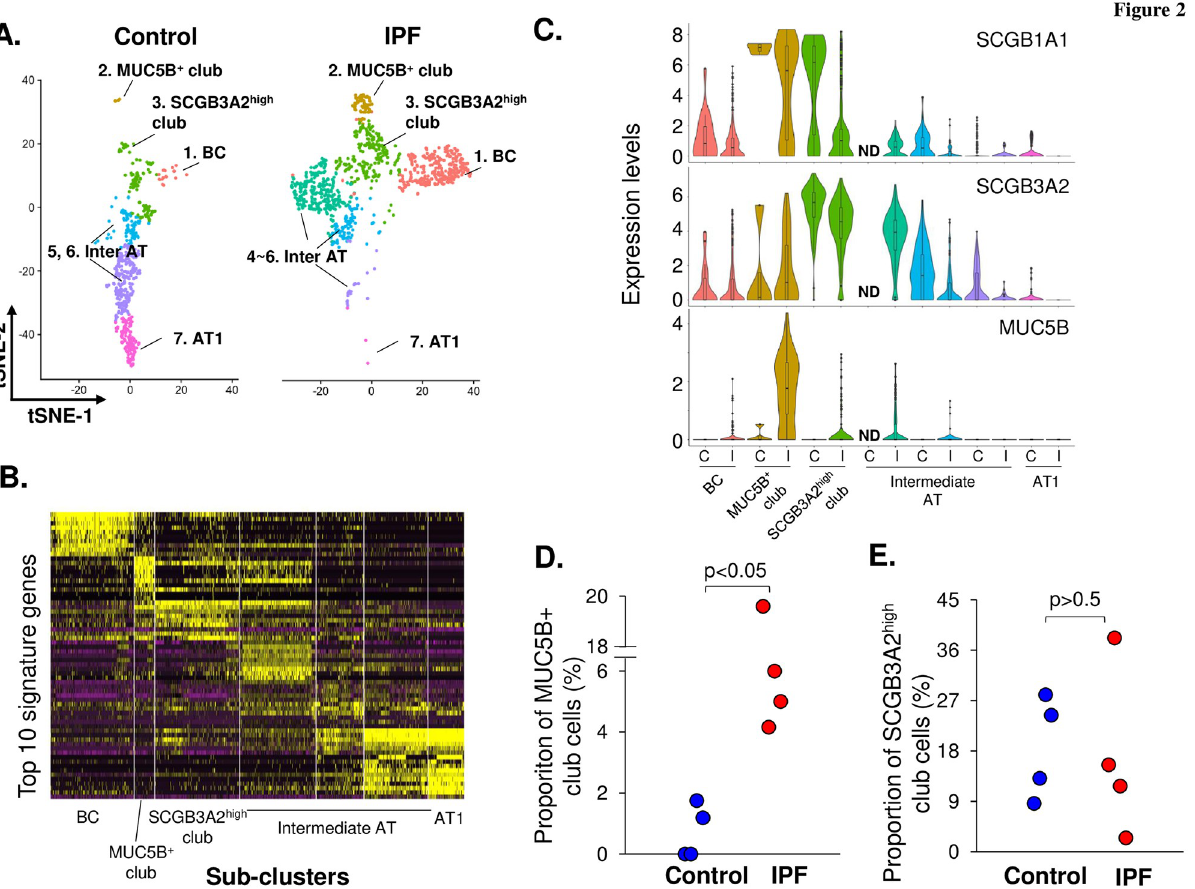
Fig 2. Identification of club cell sub-populations from the human lung of controls vs IPF patients by single cell RNA-sequencing. A. Unsupervised t-SNE clustering of the single cells from airway epithelial and alveolar cell cluster (cluster 1) in Fig 1A and 1C. A total of 6 unique cell populations were identified in controls ( left ) and 7 unique cell populations in IPF patients ( right ). Based on the signature genes for each cell population (see S3 Table and S3A Fig in S1 File), these cell populations were defined as: (1) basal cells–highly expressing KRT5; (2 and 3) club cells–highly expressing SCGB1A1; (4– 6) intermediate alveolar cells–expressing type I alveolar cell markers AGER and HOPX, and type II alveolar cell marker SFTPC and ABCA3; (7) type I alveolar cells–highly expressing both AGER and HOPX. B. Heatmap plot in the expression of top 10 signature genes from the 7 unique cell populations identified in panel A. C. Violin plots showing the expression of club cell genes SCGB1A1 (top) , SCGB3A2 (middle) , and IPF genetic risk factor gene MUC5B (bottom) in the cell populations from control (C) and IPF (I) donors identified in panel A . Based on the violin plots, the sub-cluster 2 and 3 were defined as SCGB1A1 + MUC5B + and SCGB1A1 + SCGB3A2 high club cells, respectively. Note that sub-cluster 4 was not detected (ND) in control cell populations. D. Fraction of the SCGB1A1 + MUC5B + club cell sub-population in controls vs IPF patients. E. Fraction of the SCGB1A1 + SCGB3A2 high club cell sub-population in controls vs IPF. In panels D - E. , each dot represents one individual. Blue dots –controls, red dots –IPF patients. p values are shown.